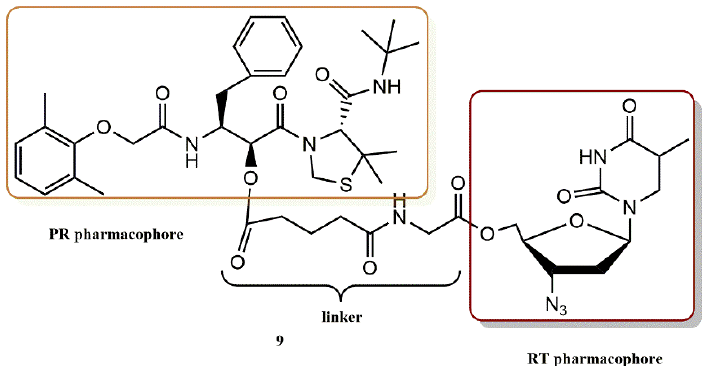
Figure 11. RT and PR pharmacophores of new active synthesized compound 9 .